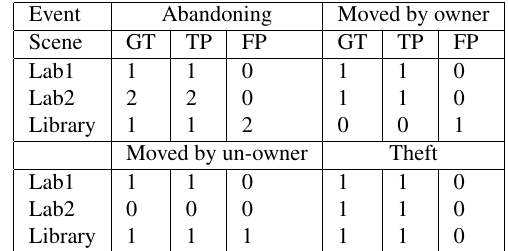
Figure 8: An example of experimental resutls on SERD of library scene.